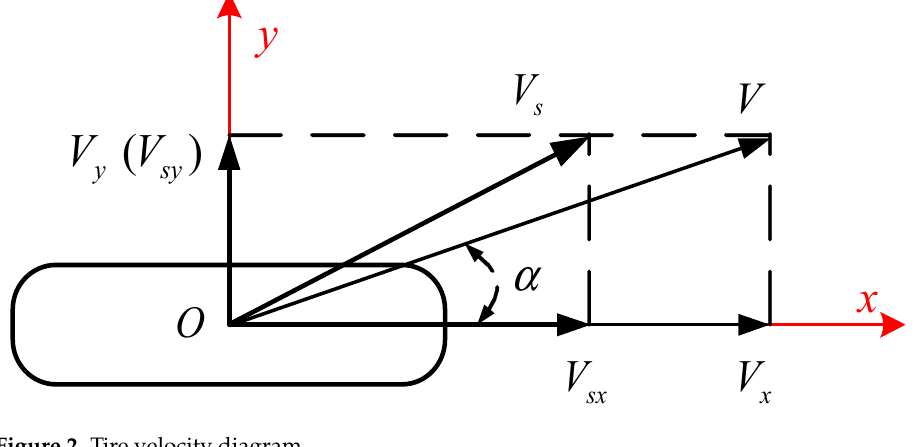
Figure 2. Tire velocity diagram.